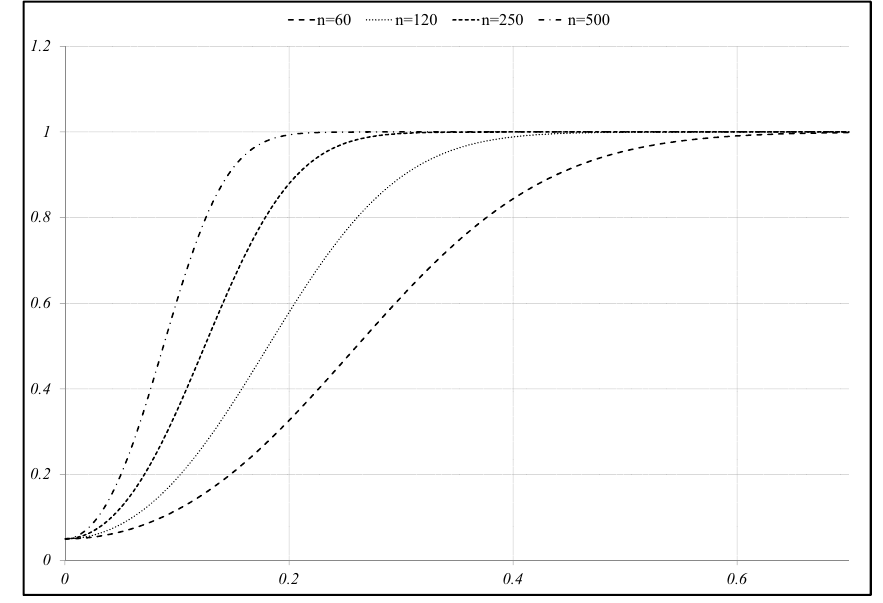
Figure 1. Power function for n ∈ { 60, 120, 250, 500 } and γ =